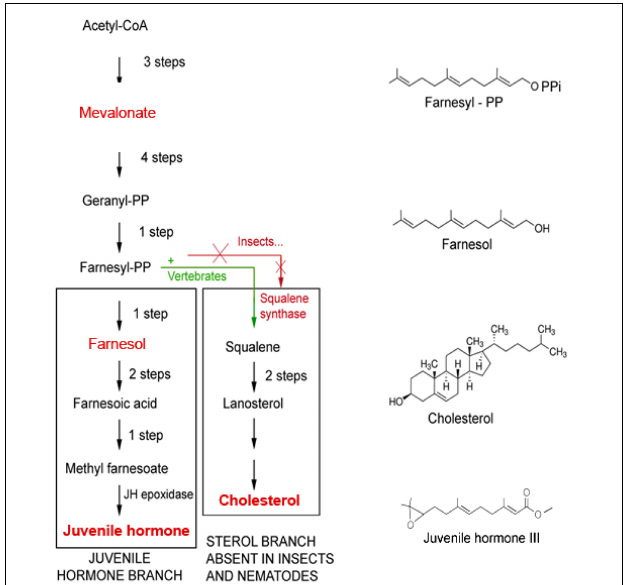
proteins in which an intramolecular microchannel exists, that upon being stretched by, e.g., ligand binding-dependent allosteric changes, allows some Ca 2 + or/and H + to enter the